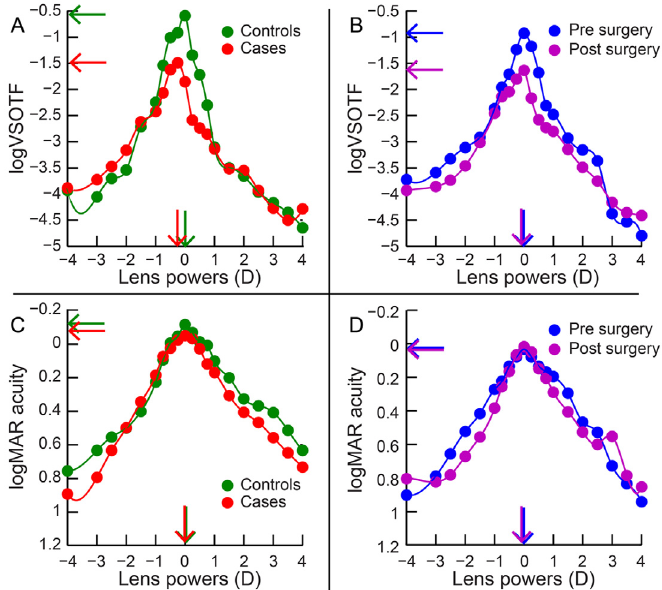
Fig 2. Average computational (panels A and B) and psychophysical (panels C and D) through-focus curves of all subjects obtained by plotting logVSOTF or logMAR acuity for each induced myopic and hyperopic lens power The solid circles indicate individual data points while the curve indicate the spline fit to the data. Panels A and C show through-focus curves for the first arm of the study while panels B and D show through-focus curves for the second arm of the study. Horizontal and vertical arrows in each panel indicate peak IQ and best focus location, respectively.